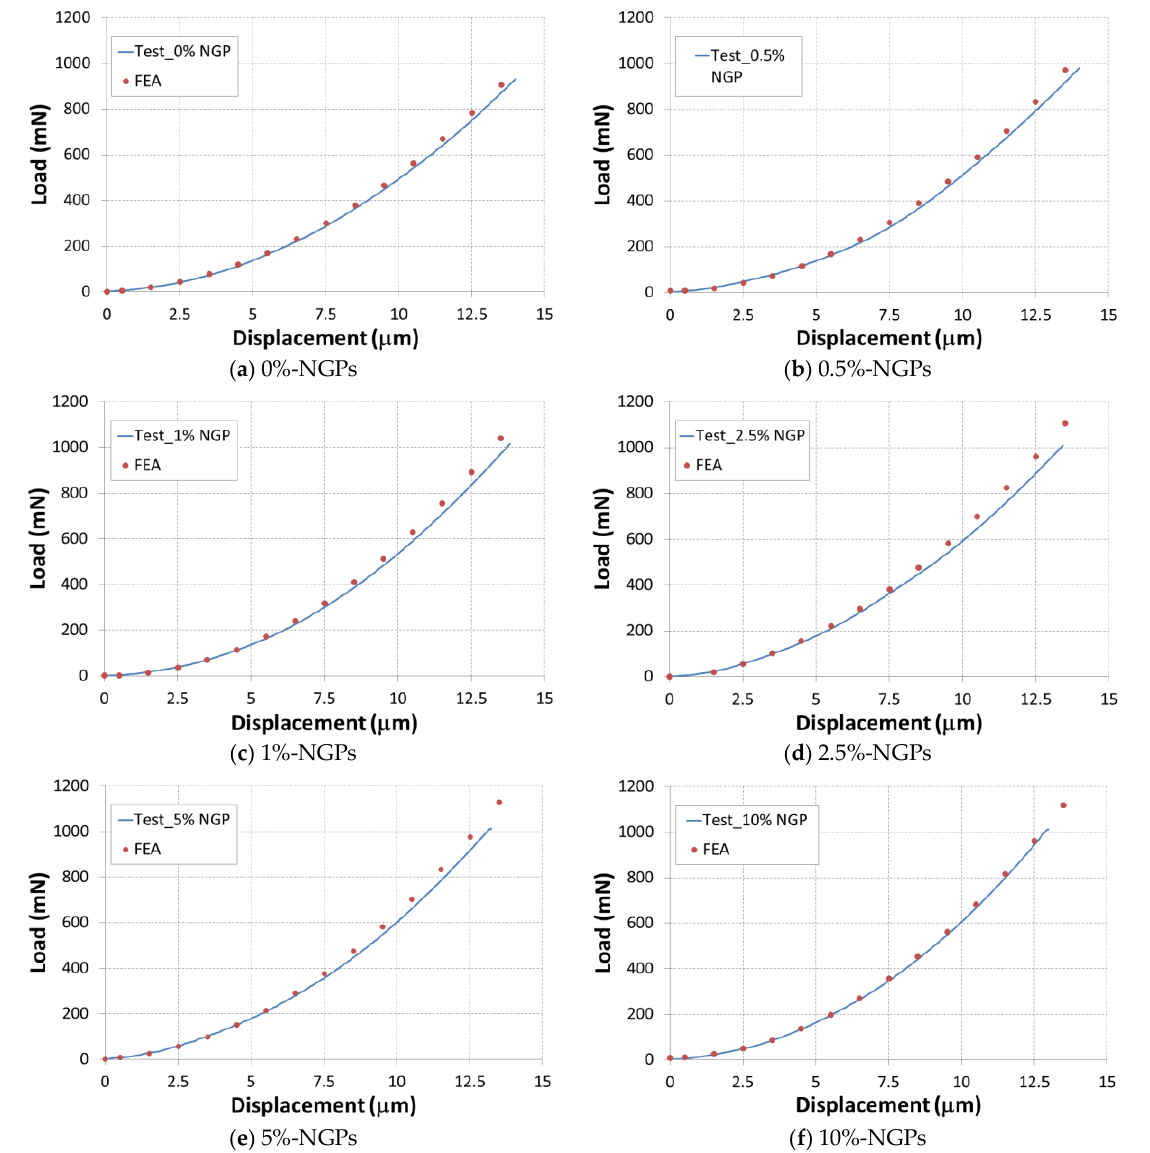
Figure 20. Experimental test and numerical simulations of micro-Indentation, loading zone.